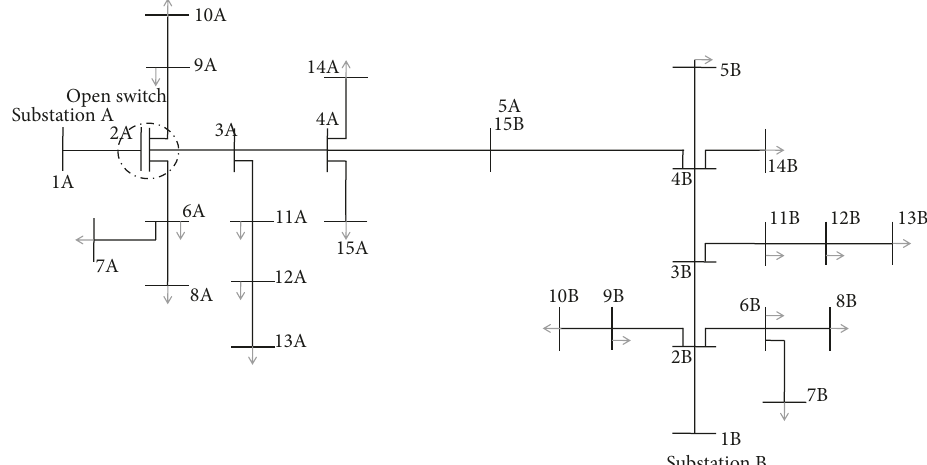
Figure 10: Topology structure resulting from closing the node 5A–15 and opening the switch of the node 2A.